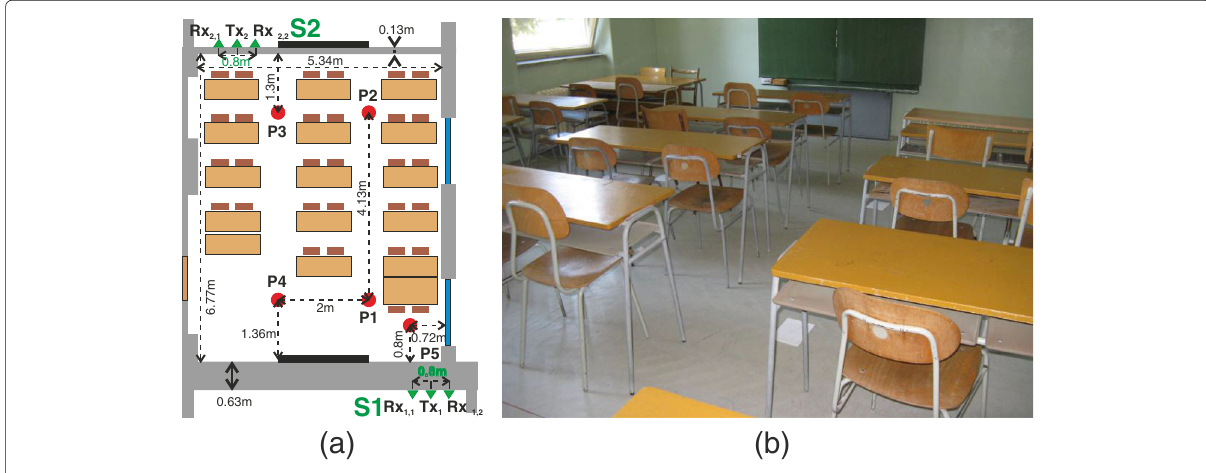
Fig. 3 Experimental scenario. a The measurement scheme. b The interior of the monitored